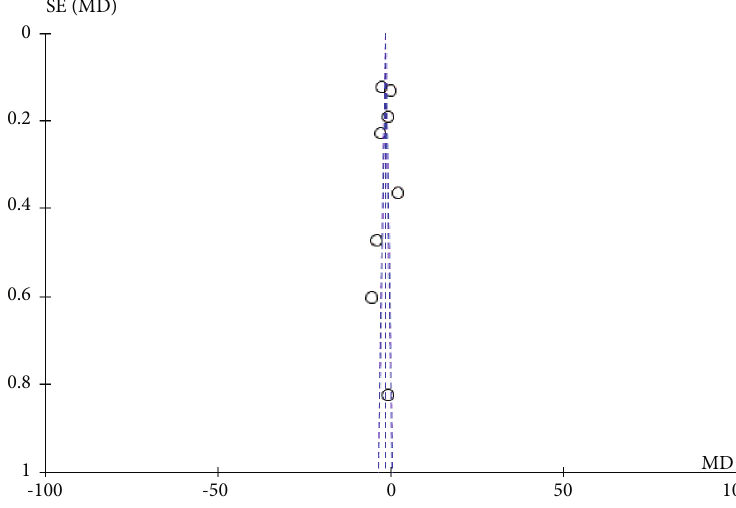
Figure 7: The funnel plots for e ff ect were